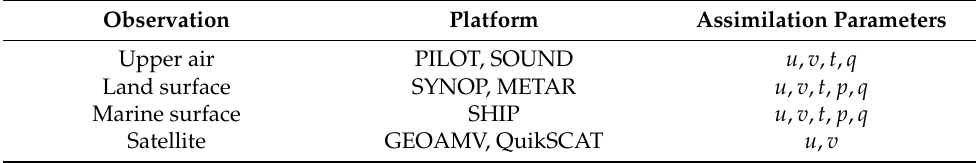
Table 1. Datasets assimilated for the CNTL experiment.